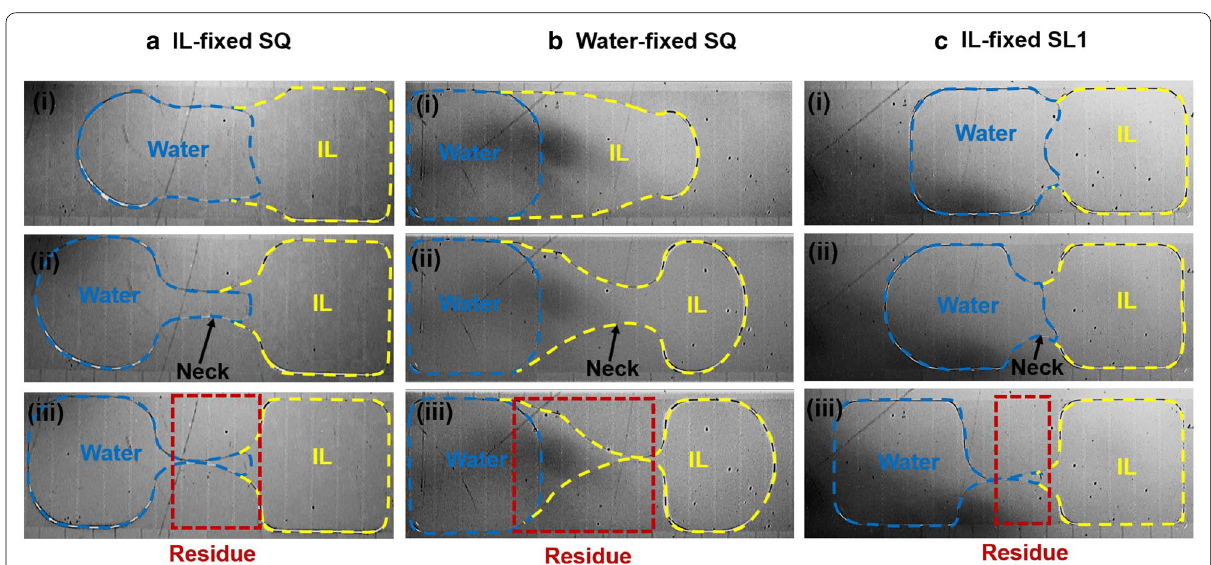
Fig. 9 Profiles of droplet deformation during the phase separation process. a IL-fixed SQ scheme, b water-fixed SQ scheme, and c IL-fixed SL1